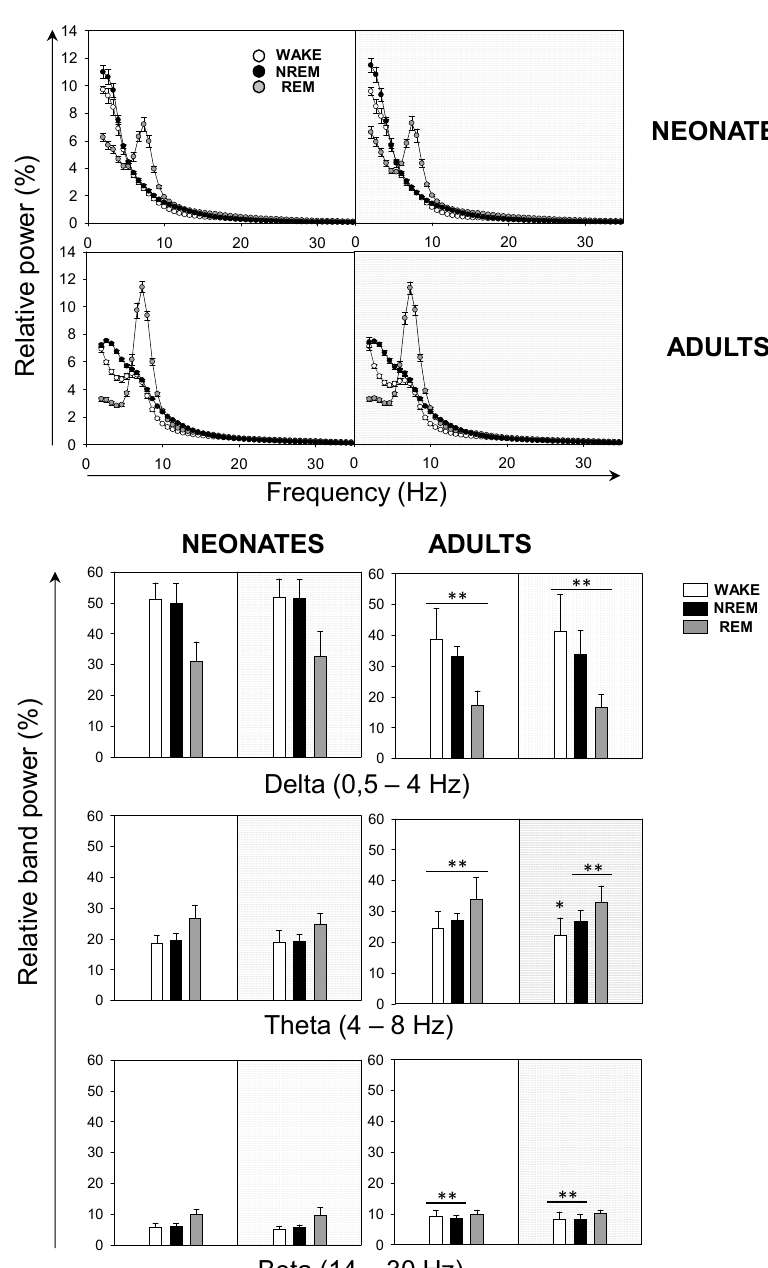
Figure 4. Sleep–wake EEG spectra during behavioral states in neonatal and adult mice. ( A ) Influence of light/dark cycle in the relative power of EEG during behavioral states in neonatal (top panels) and adult (bottom panels) mice. ( B ) Relative band power of EEG in delta ( δ ), theta ( θ ), and beta ( β ) during behavioral states. Data shown as mean ± SEM of either 18 or 27 recordings retrieved from 6 neonatal or 11 adult mice, respectively. Asterisks denote significant differences between neonatal and adult mice: * p < 0.05; ** p < 0.01; Two-way ANOVA and Tukey’s test for post-hoc analysis.